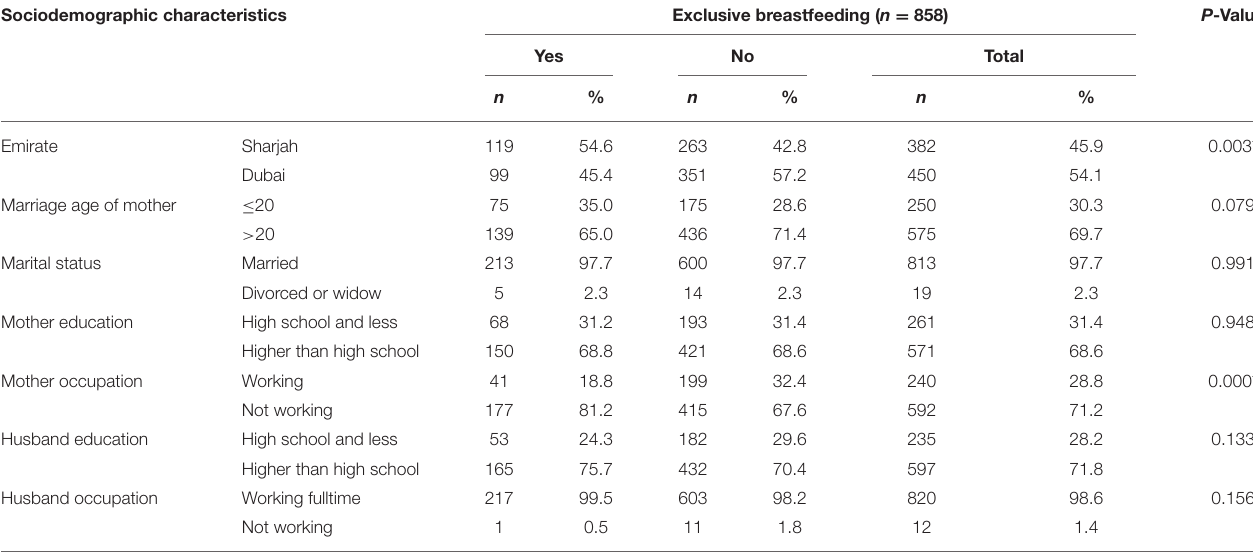
TABLE 2 | Association between EBF and women’s sociodemographic characteristics. Sociodemographic characteristics